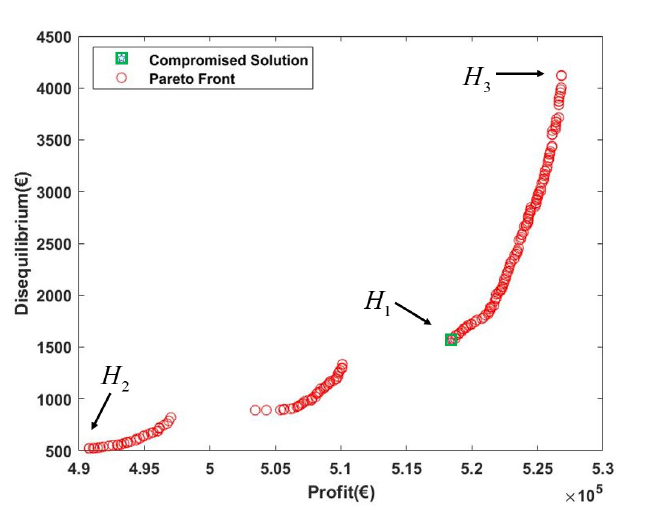
Figure 12. The Pareto front.